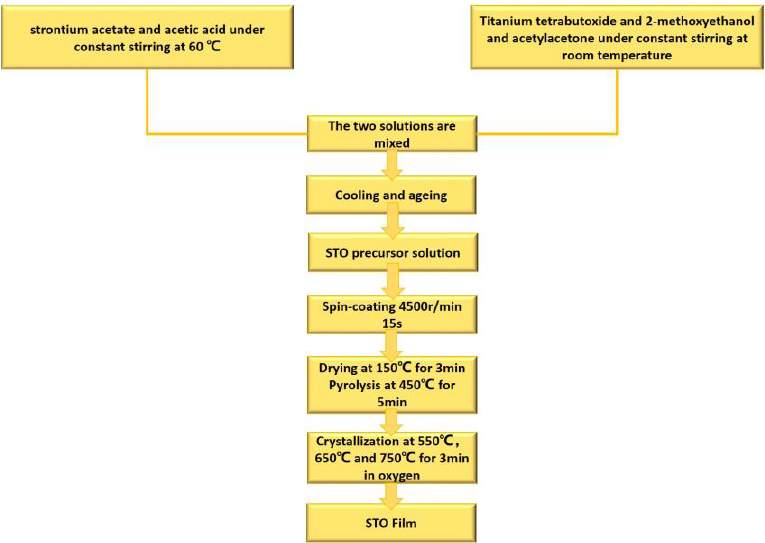
Figure 1. Flow chart for the preparation of the STO films in a sol – gel